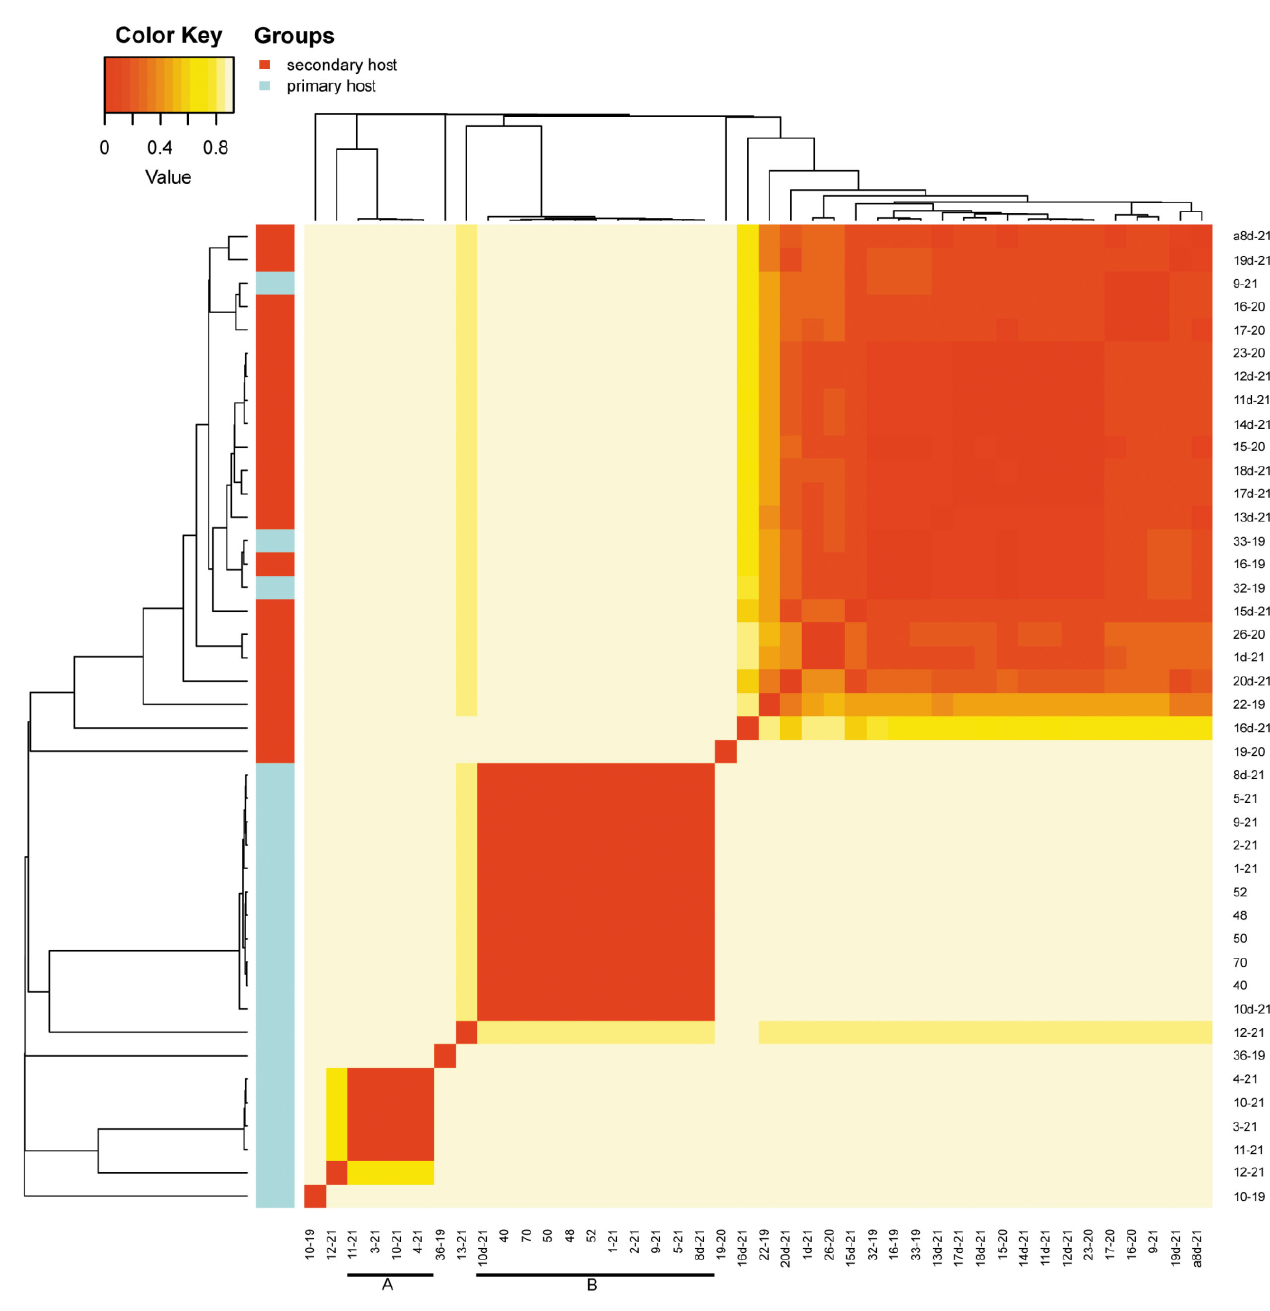
Figure 9. Heatmap of OTU beta diversity clustered with the Bray method in reference to host plants of studied samples (sample numbers as in Supplementary Table 1; bars with letters mark clades). of studied samples (sample numbers as in Supplementary Table S1; bars with letters mark